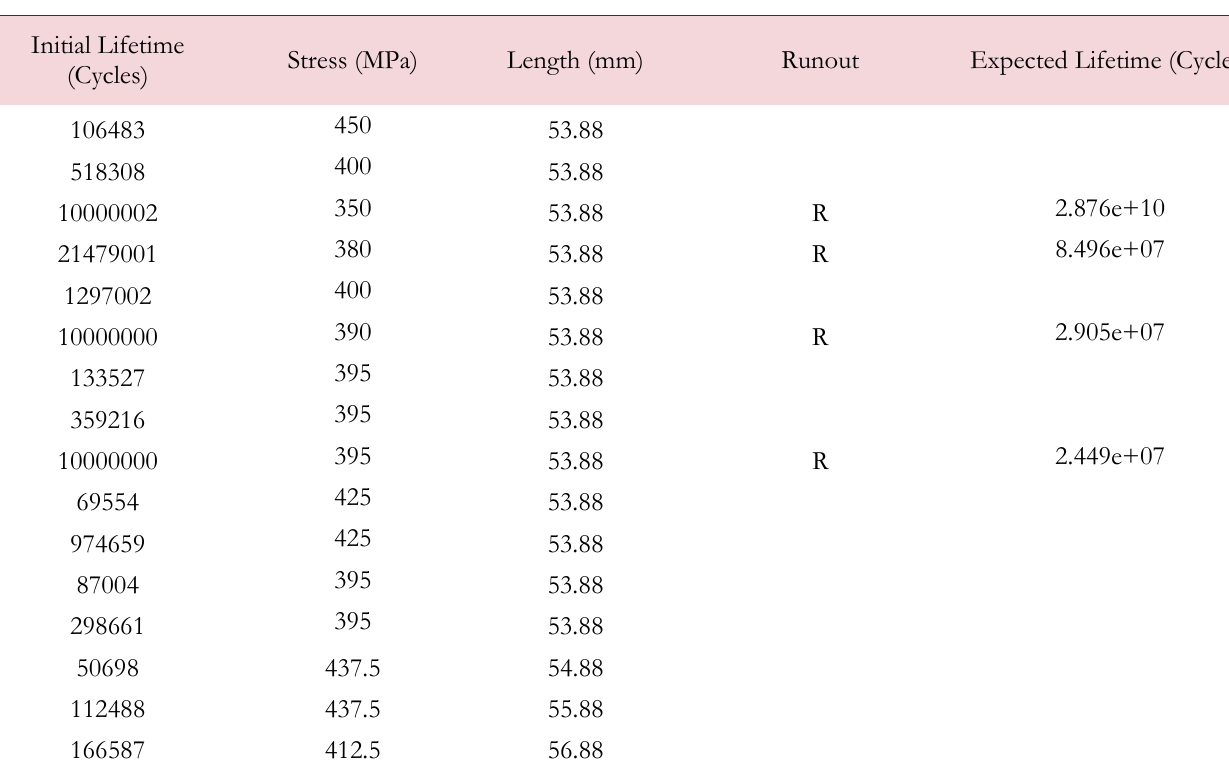
Table 1: Fatigue results from the resonance tests.